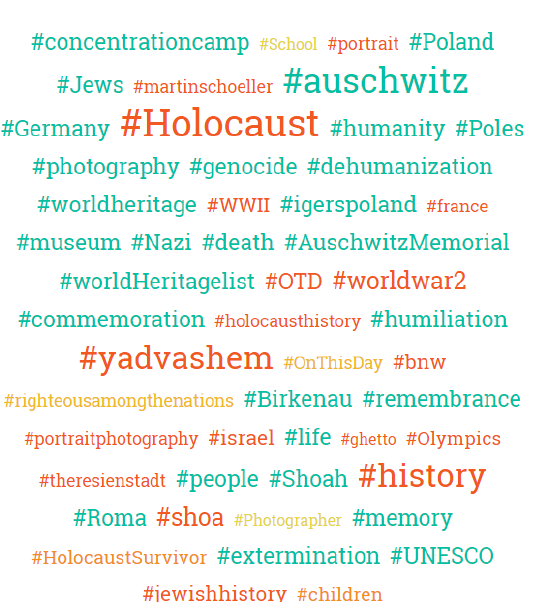
Figure 3. Hashtags that the museums used most frequently on Instagram (relative frequency is expressed both by text size and by colour).